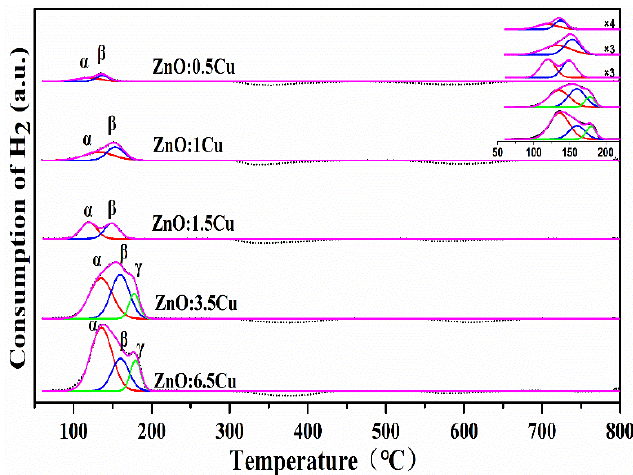
Figure 5. Hydrogen temperature-programmed reduction (H 2 -TPR) profiles of ZnO:XCu model catalysts, X = 0.5, 1.0, 1.5, 3.5, 6.5.